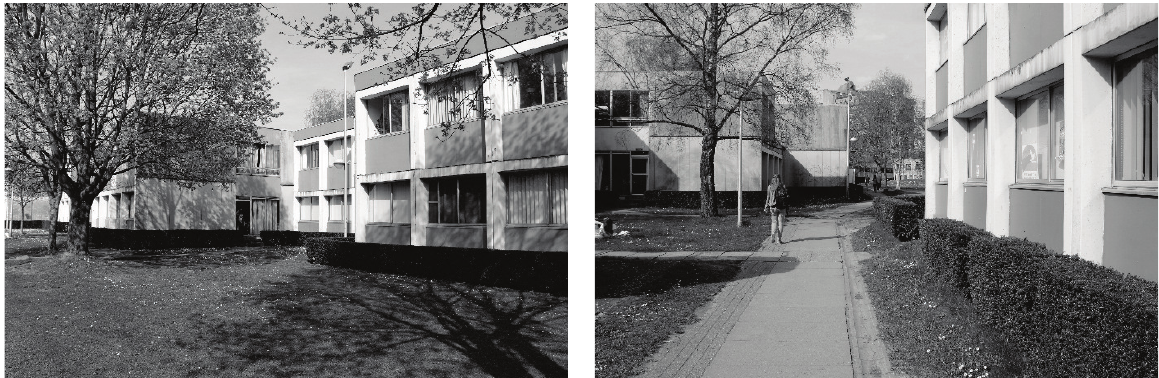
Figure 1. The student residences, characteristic of far-reaching industrialisation, have become obsolete after more than 40 years. However, their concrete frames can still be reused. (Pictures by the